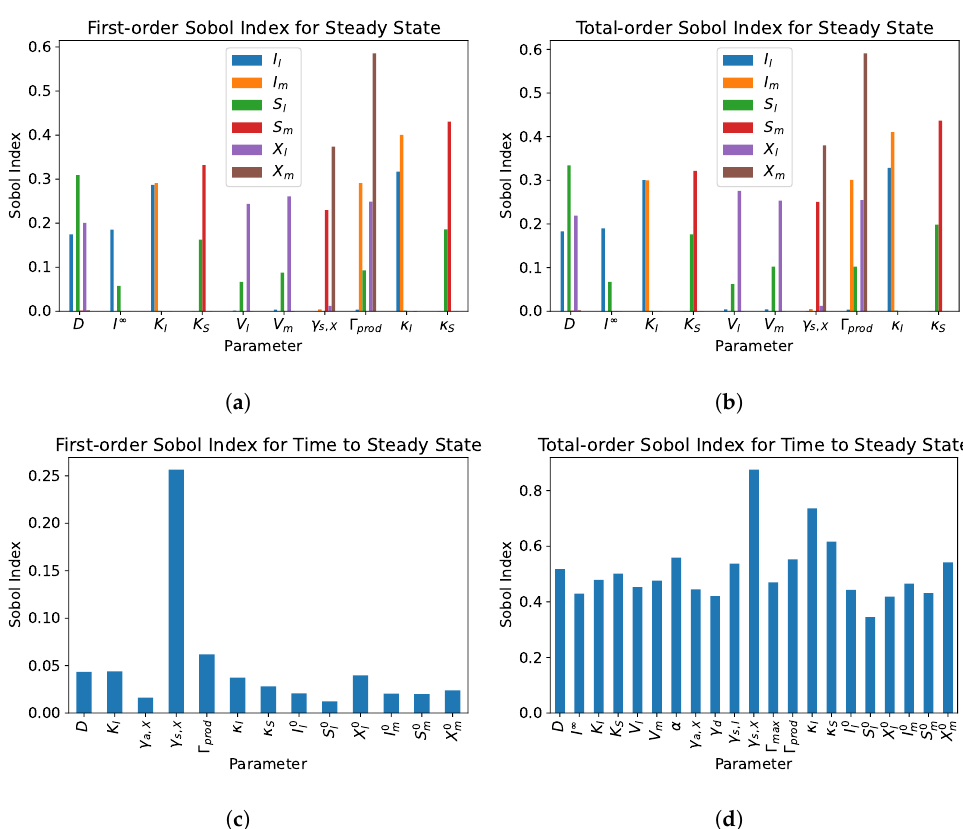
Figure 10. ( a ) First-order and ( b ) total effect sensitivity indices of steady-state values of fiber I l , mucin I m , luminal sugar S l , mucosal sugar S m , luminal biomass X l and mucosal biomass X m . Parameters with sensitivity indices below 0.1 for all variables were omitted for ( a , b ). ( c ) First-order and ( d ) total effect sensitivity indices of time to steady state of fiber I l , mucin I m , luminal sugar S l , mucosal sugar S m , luminal biomass X l and mucosal biomass X m . Parameters with sensitivity indices below 0.01 were omitted for ( c , d ). Sampling was conducted with a variance of 20% on input parameters, excluding yield coefficients. Mean values were taken from Table 2.